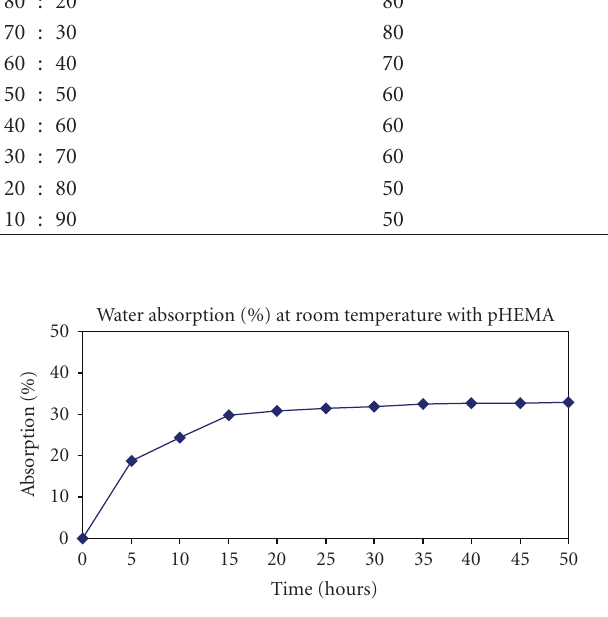
Figure 1: pHEMA shows water absorption of ∼ 40 wt.% and remains transparent throughout.